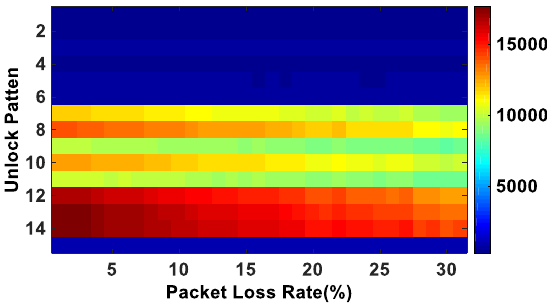
Figure 6. Influence of packet rate loss on calculated DTW distances between two